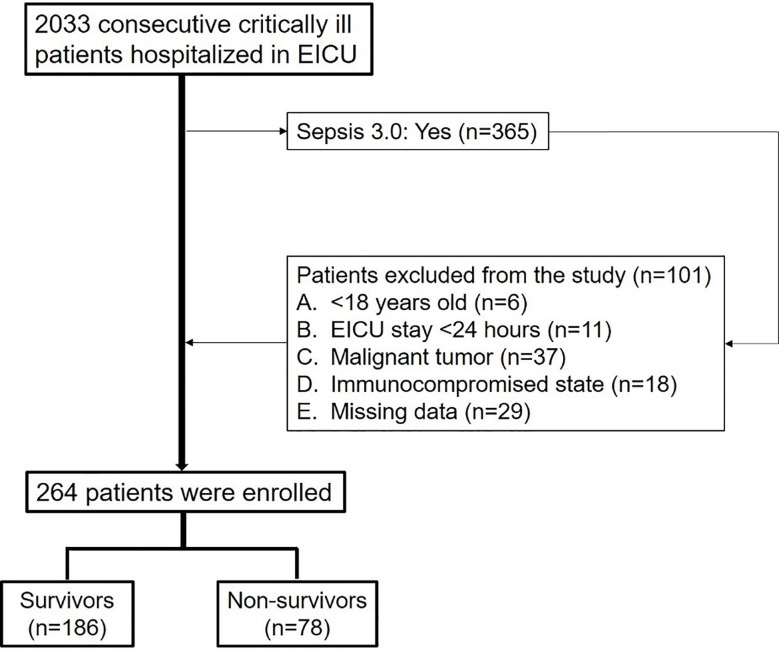
Flowchart of the enrolled patients.